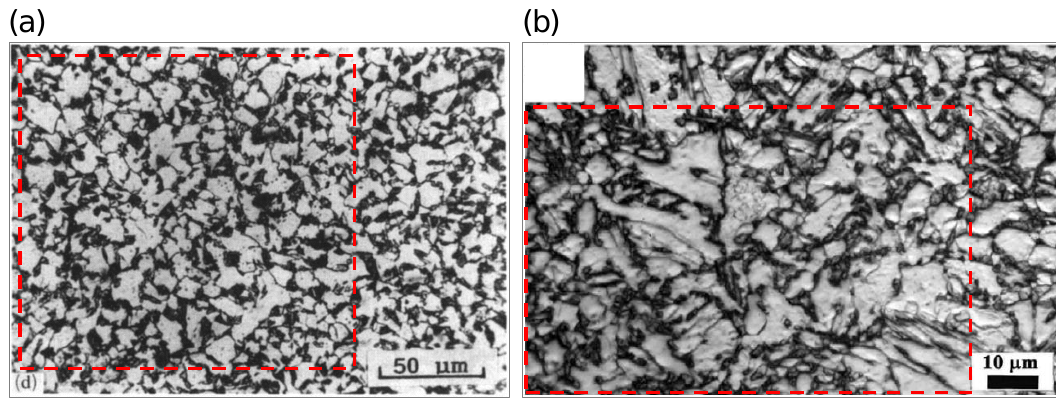
Figure 14. Optical micrographs of ( a ) DP5, reproduced from [63], with permission from Elsevier, 1992, and ( b ) DP2, reproduced from [64], with permission from John Wiley and Sons, 2016, respectively, where the areas indicated by red broken lines were used in FEM